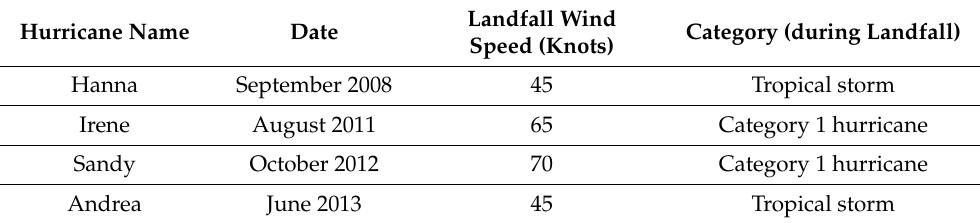
Table 6. List of the major storms that occurred near our study area between 2007 and 2015 with their associated wind speed and category when the storm made